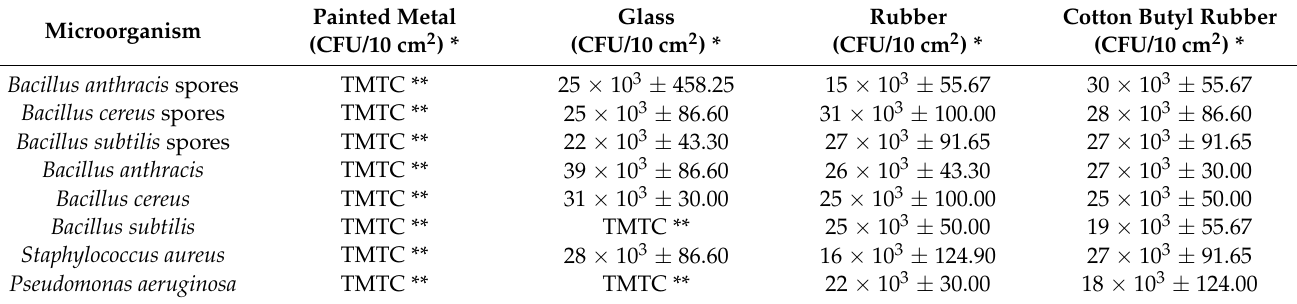
Table 2. Control ‡ of initial contamination level of the tested surfaces.